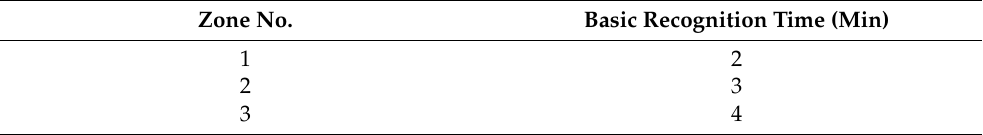
Table 2. Basic recognition time for various zones.